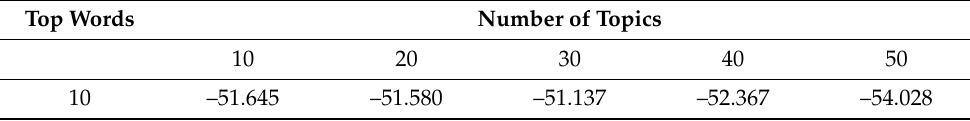
Table 1. Coherence measures for the choice of the number of topics in the LDA model. Top